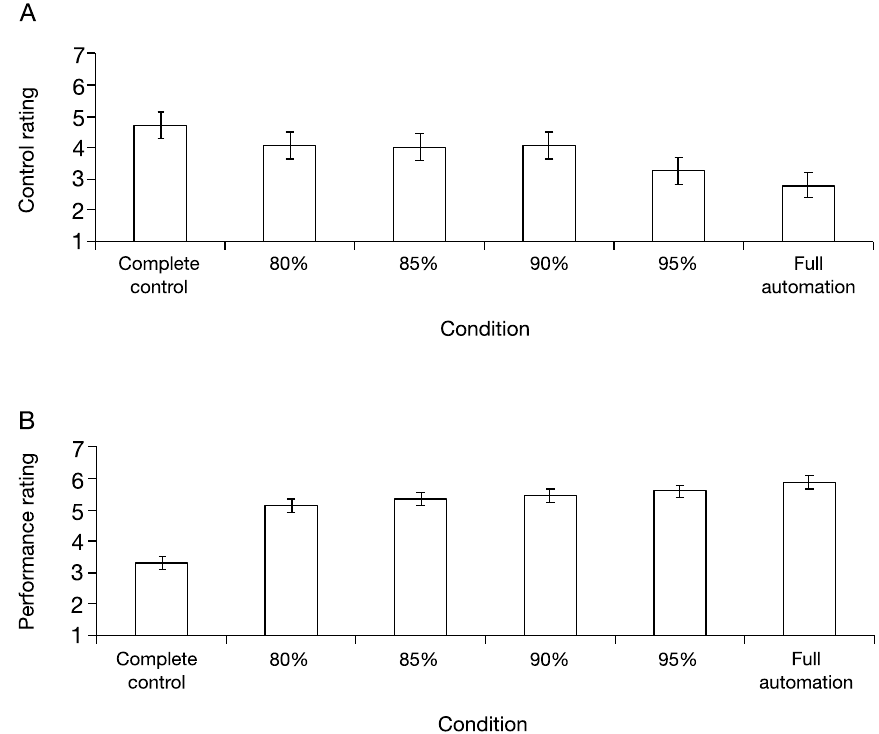
Figure 5. Average self-reported ratings for each condition. Statistical comparisons revealed that the 95% and the full automation conditions were significantly lower than the complete control condition in terms of control rating ( A ), but higher in terms of performance rating ( B ). “Complete control,” 80%, 85%, 90%, 95%, and “Full automation” denote the complete control, 80% automation, 85% automation, 90% automation, 95% automation, and full automation conditions, respectively. Error bars represent 95% within-subjects confidence intervals 39